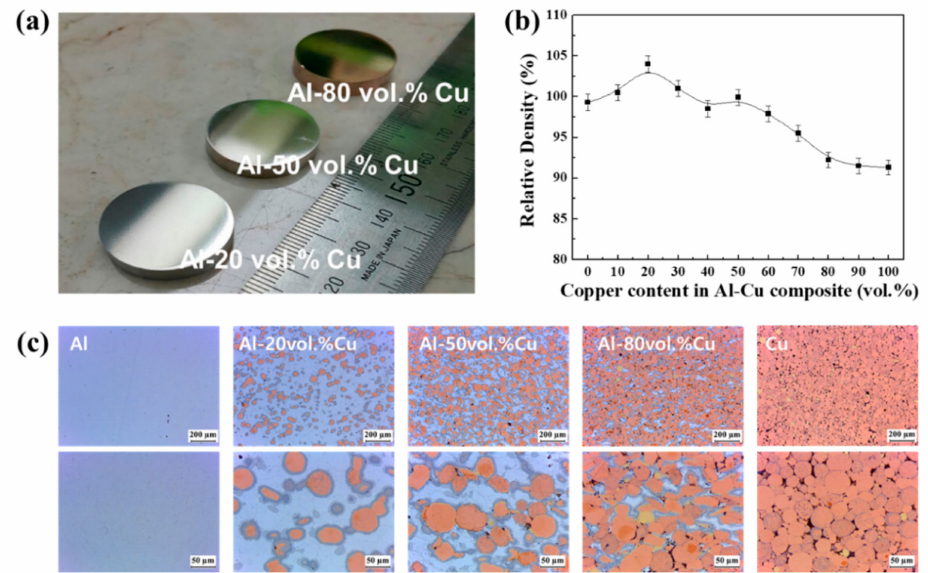
Figure 2. ( a ) Photograph of the Al–Cu composites after spark plasma sintering (SPS), ( b ) evolution of the relative density of composites, and ( c ) cross-sectional light microscopy images.